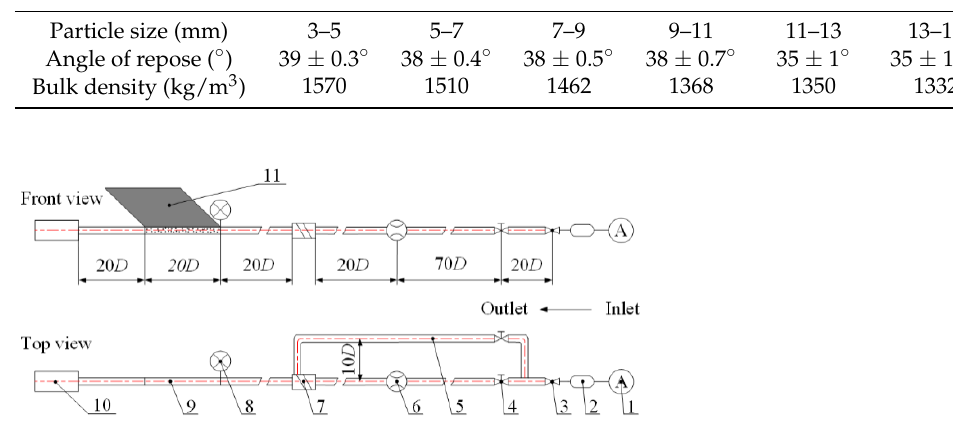
Figure 2. Slump test of pebble particles in the experiments. Table 1. Particle sizes and their properties.